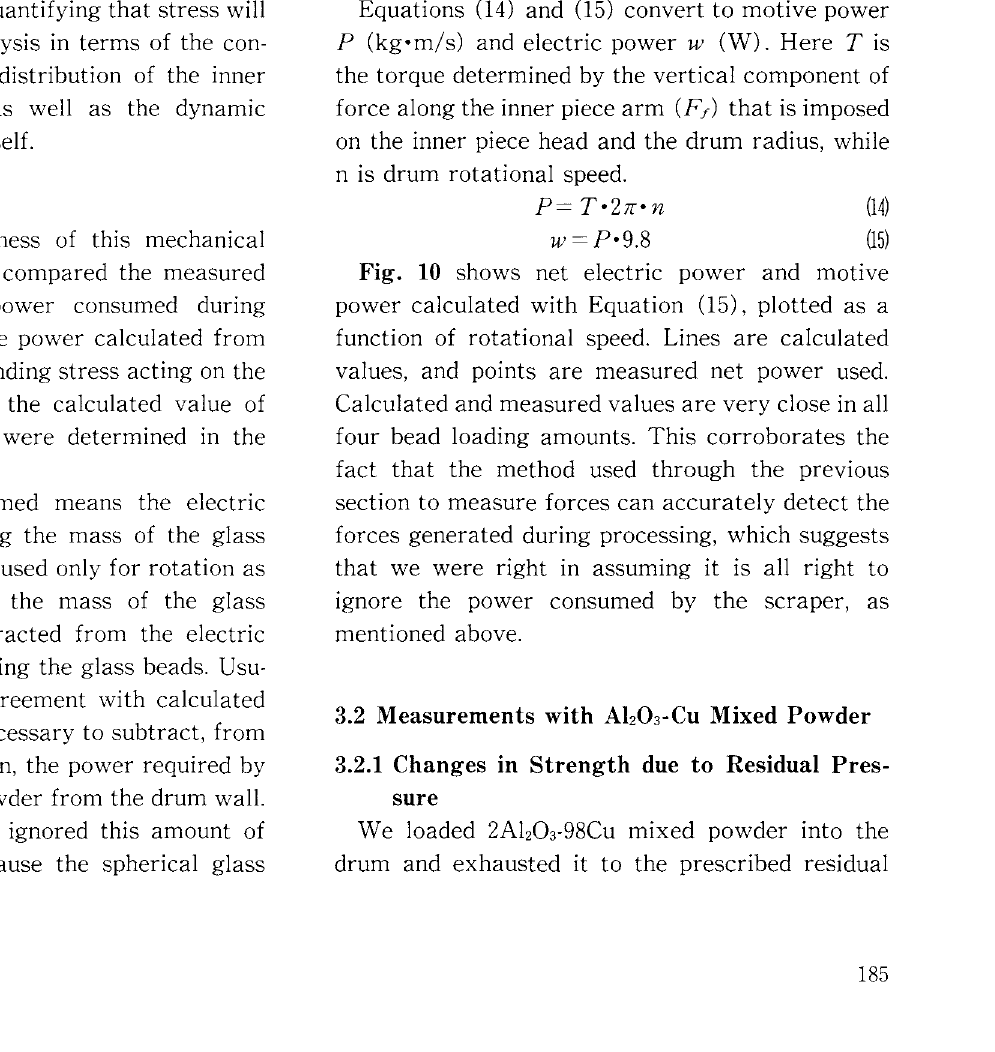
Fig. 10 Variation in power consumption with drum rotational speed as a parameter of amount of glass beads. The symbols and lines correspond to the measured values and the lines calculated by Eq. (15),